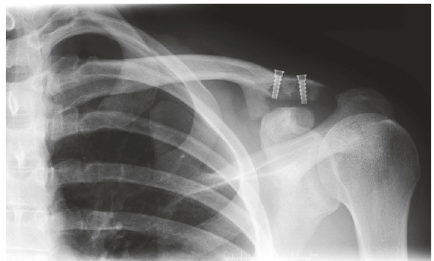
Figure 4: Anteroposterior left ACJ radiograph two months after re- do LARS implantation showing anatomically reduced ACJ.